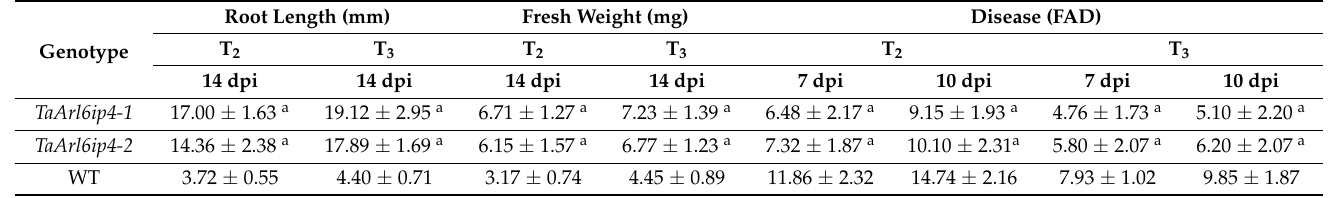
Table 2. DON tolerance and Fusarium–Arabidopsis disease (FAD) assays of TaArl6ip4 transgenic Arabidopsis .